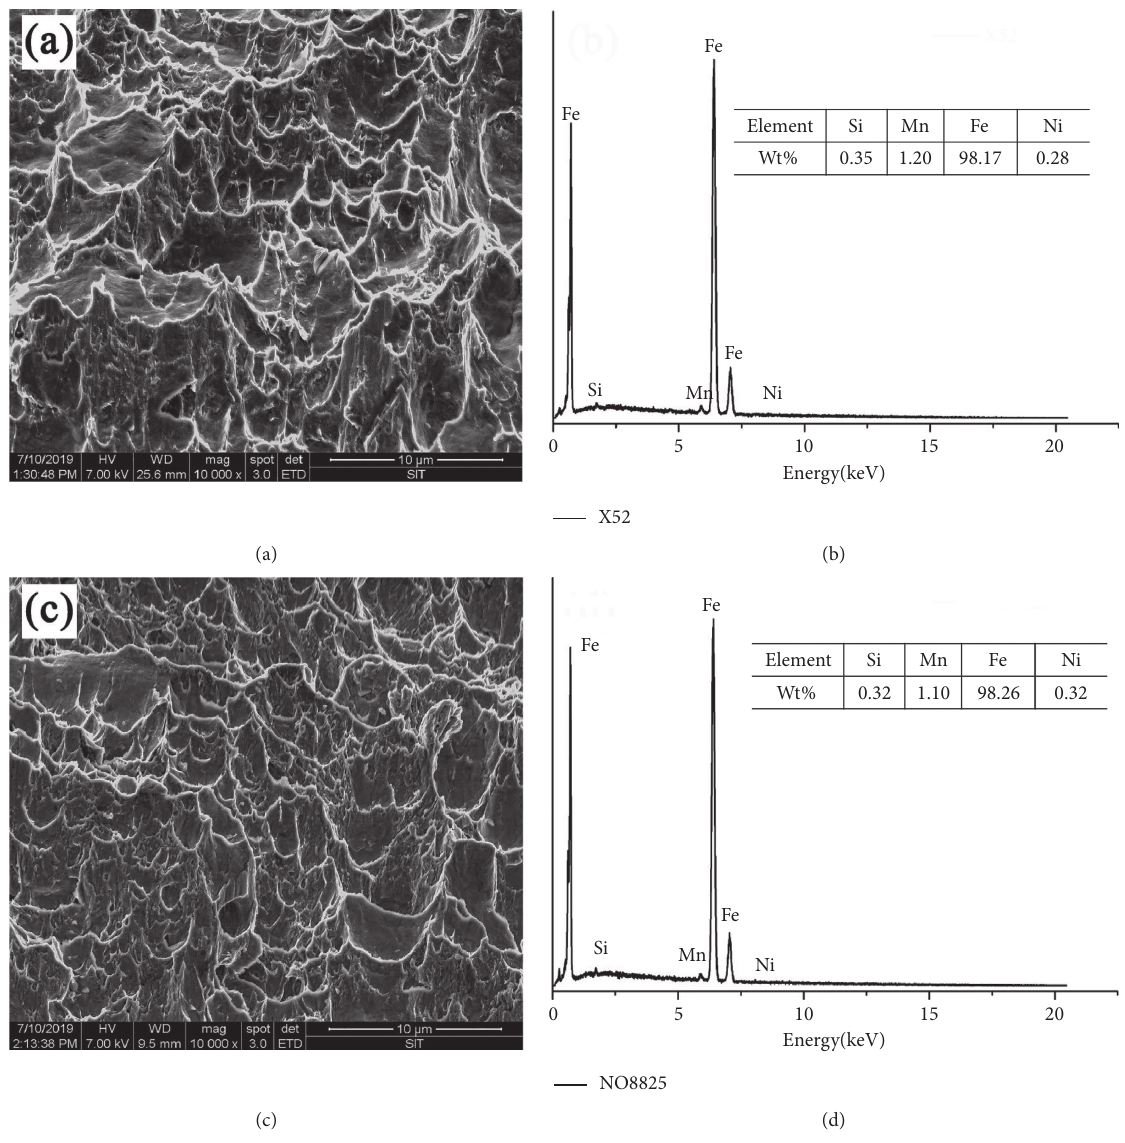
Figure 7: Microstructures of shear fracture and EDS on both sides of the shear sample: (a) fracture microstructure of the left side of the shear sample, (b) EDS of the left side of the shear sample, (c) fracture microstructure of the right side of the shear sample, and (d) EDS of the right side of the shear